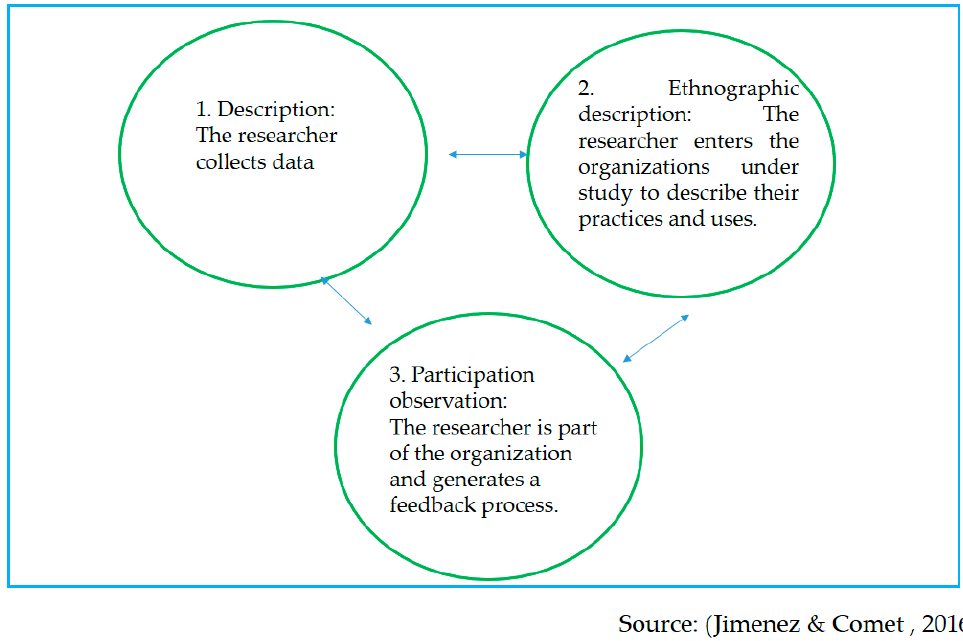
Figure 2. The role of the researcher in case studies